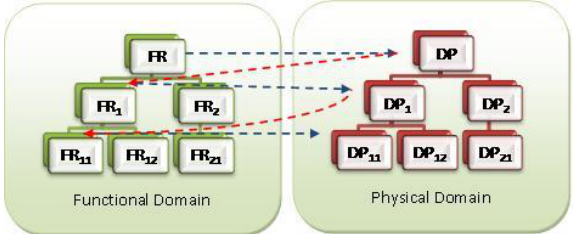
Figure 2. Decomposition by